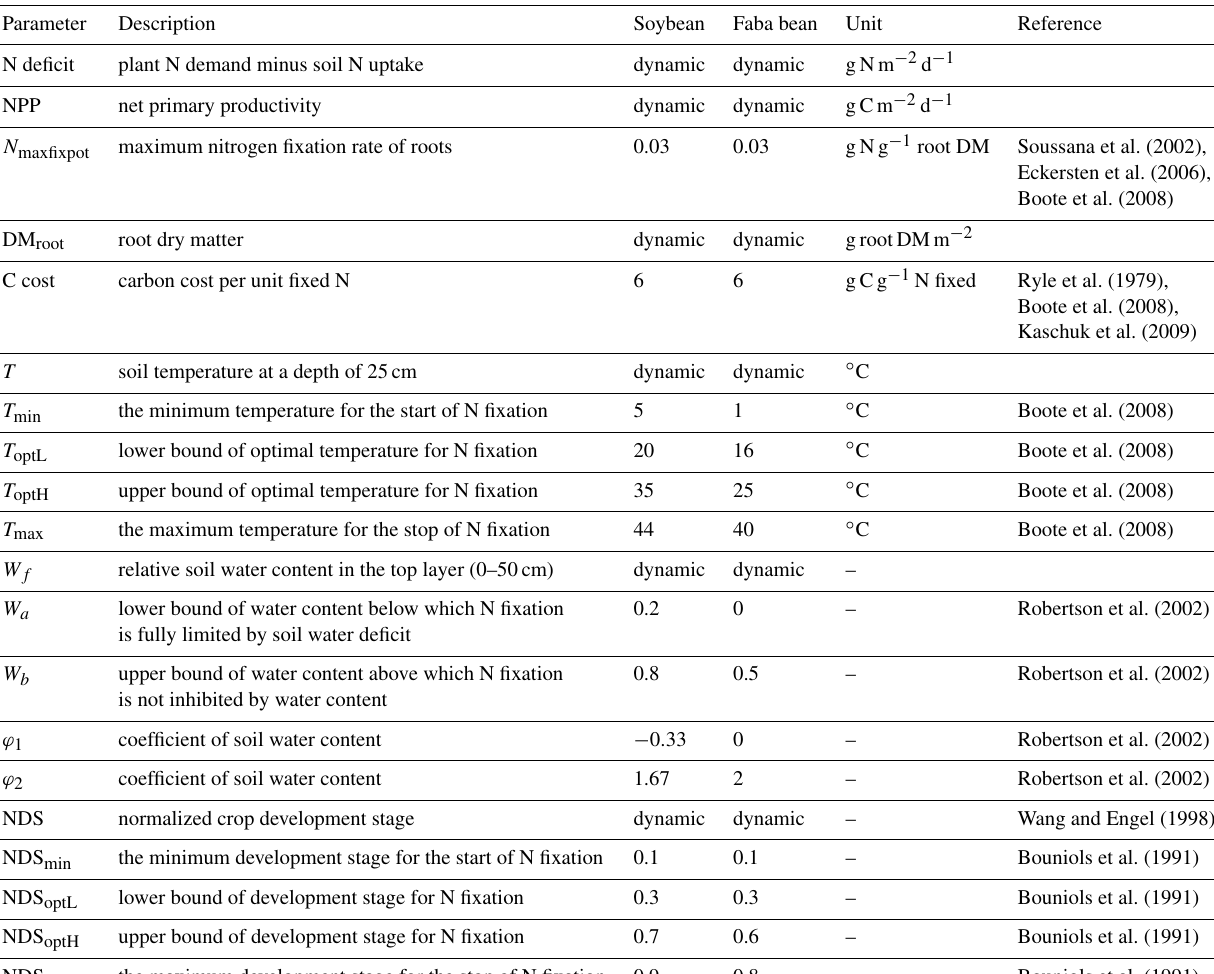
Table 1. Overview of BNF-related variables and parameters used in the model for soybean and faba bean.